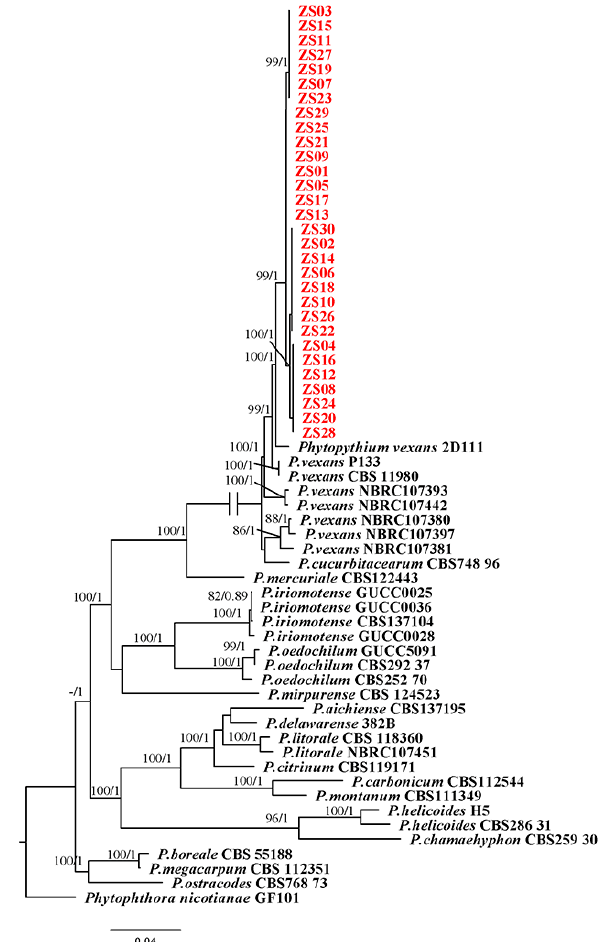
Figure 2. Phylogenetic tree obtained from Bayesian analysis of the combined coxI , coxII , ITS , LSU rDNA and β -tubulin sequence alignment of all accepted species of Phytopythium . The bootstrap support values and Bayesian posterior probabilities are given at the nodes (MLBS/BPP). The red font indicates the isolates obtained in this study. ZS01-ZS30 were the isolates in this experiment. Bootstrap values below 70% and posterior probabilities below 0.70 are not shown.